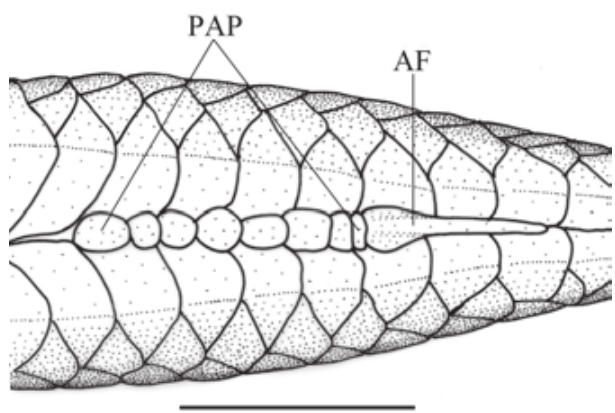
Fig. 2. Pareiorhaphis ruschii , MCP 44807, paratype, 53.1 mm SL. Postdorsal trunk, dorsal view. Odontodes omitted. AF, Adipose fin; PAP, Preadipose azygous plates. Scale bar = 5 mm.